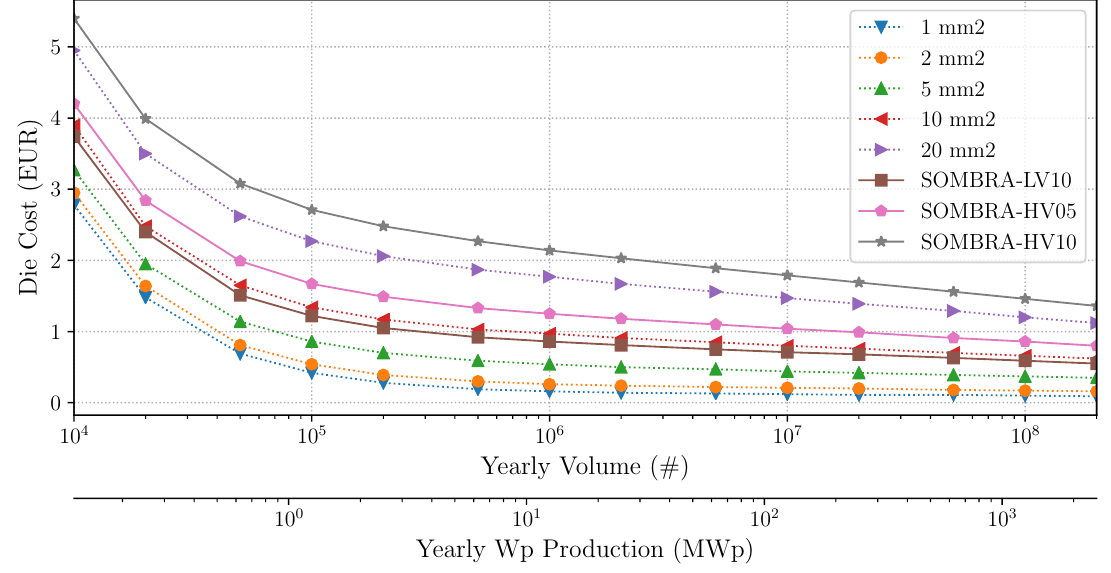
Figure 14. Chip cost for dies of different sizes versus yearly production volume. Assuming 20 devices and 250 Wp per panel, this can also be expressed as yearly Wp